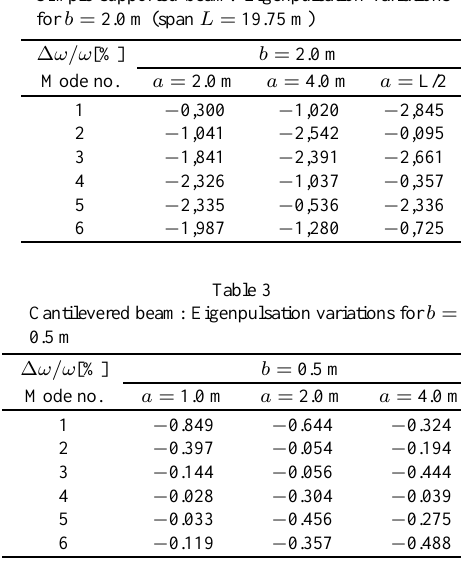
Table 2 Simple supported beam: Eigenpulsation variations